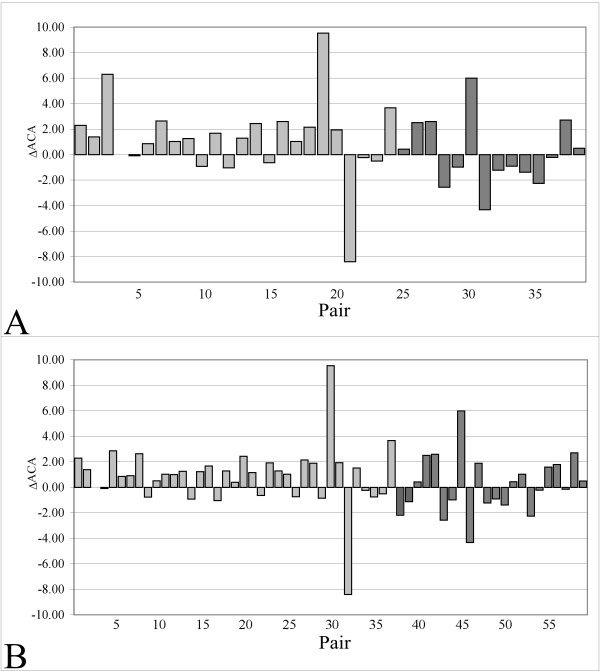
Differences in the apolar contact area (ΔACA) for each protein pair, composing dataset A and B, computed over the α-helices of the SCRs. Values for hyperthermophilic/mesophilic protein pairs and thermophilic/mesophilic pairs are expressed in Å2/residue and represented as light grey and dark grey bars, respectively. Numbers on X-axis refer to Table 1 (A) and Table 2 (B).